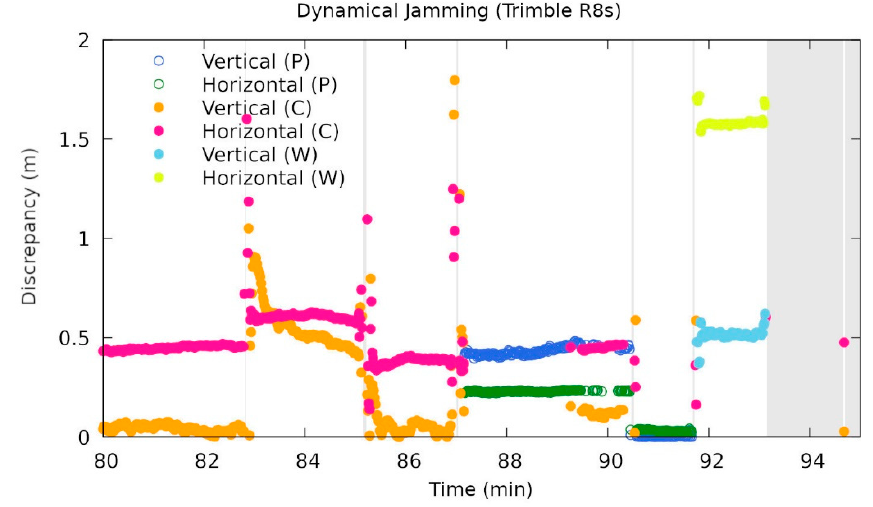
Figure 12. A zoomed area of the vertical and horizontal discrepancies during the dynamic jamming for the Trimble R8s receiver. W stands for the widelane ambiguity calculation. Note the wrong fixing in the interval from 87 to 90 min from the beginning of the experiment (08:20 UTC) (own study).